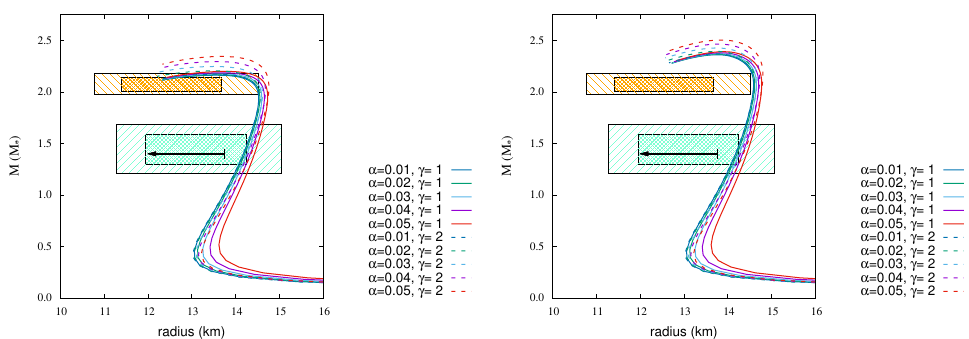
Figure 10. MR relations of DDME2-a ( left ) and DDME2-b ( right ) EoSs with magnetic fields. The strength of surface magnetic field strength B s is 10 12 G, and the central magnetic field strength B 0 is 2.5 × 10 18 G. The arrow and colored hatched areas are the same as in Figure 1. Table 11. Maximum mass ( M max ) in unit of M (cid:12) and radius (km) at M = 1.4 M (cid:12) ( R 1.4 M radius (km) at M = 2.072 M (cid:12) ( R 2.072 M ) for DDME2-a EoS with magnetic fields ( B s = 10 12 G, (cid:12) B 0 = 2.5 × 10 18 G).